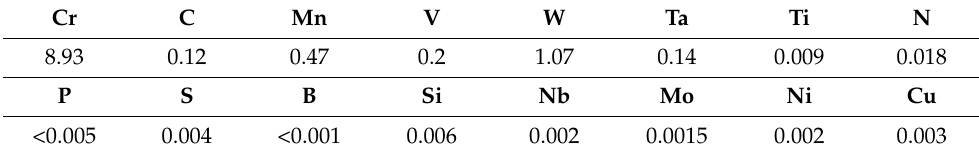
Table 1. Nominal chemical composition of EUROFER97 steel (wt.%) (Fe to balance) [1].